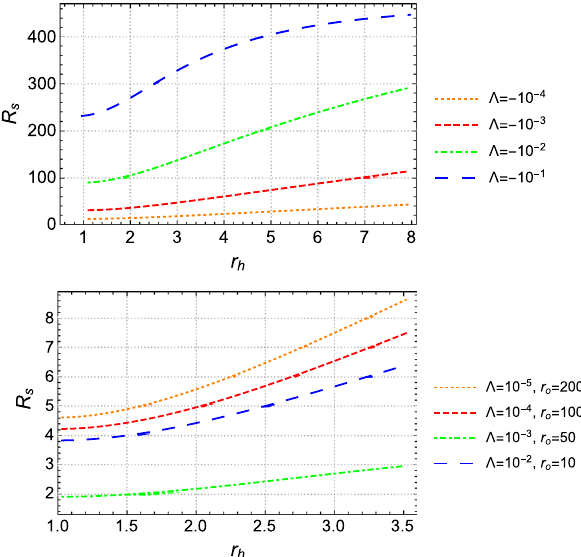
Fig. 6 The variations of the shadow radii with respect to the event horizons for the Kerr-AdS black holes (top) and the Kerr-dS black holes (bottom).Wehaveset J = 1 , θ O = π/ 2 , r O = 300forthetopdiagram and J = 1 ,θ O = π/ 2 for the bottom diagram